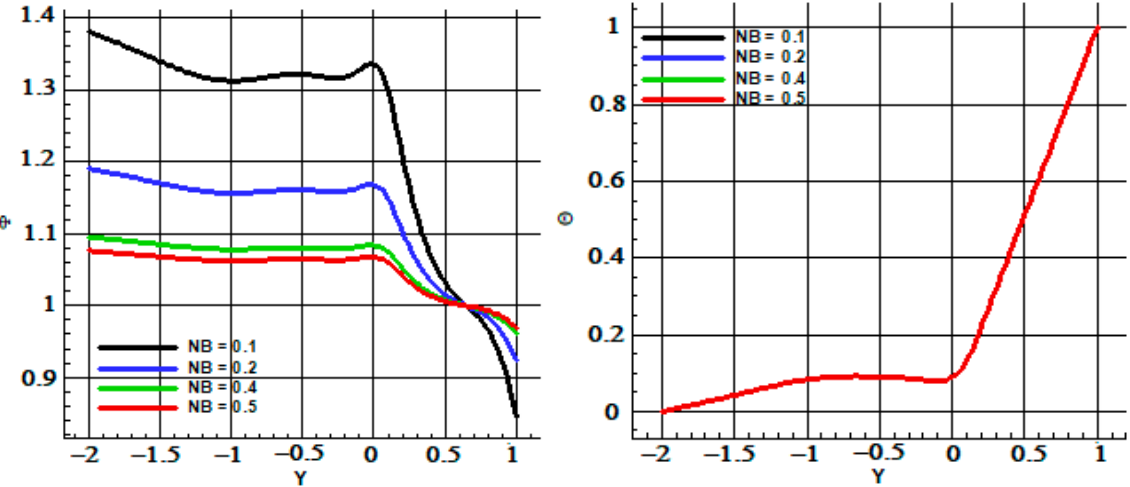
Figure 10. Concentration and temperature for different N B number and Pr = 6.2, Re = 100, Le = 1, N T = 0.1.